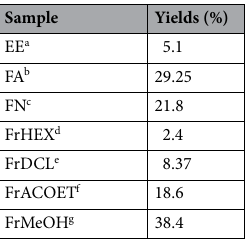
Table 1. Yields of ethanolic extract and its fractions obtained by acid–base partition or reflux extraction. a EE:ethanolic extract; b FA: alkaloids fraction; c FN: neutral fraction; d FrHEX: hexane fraction; e FrDCL: